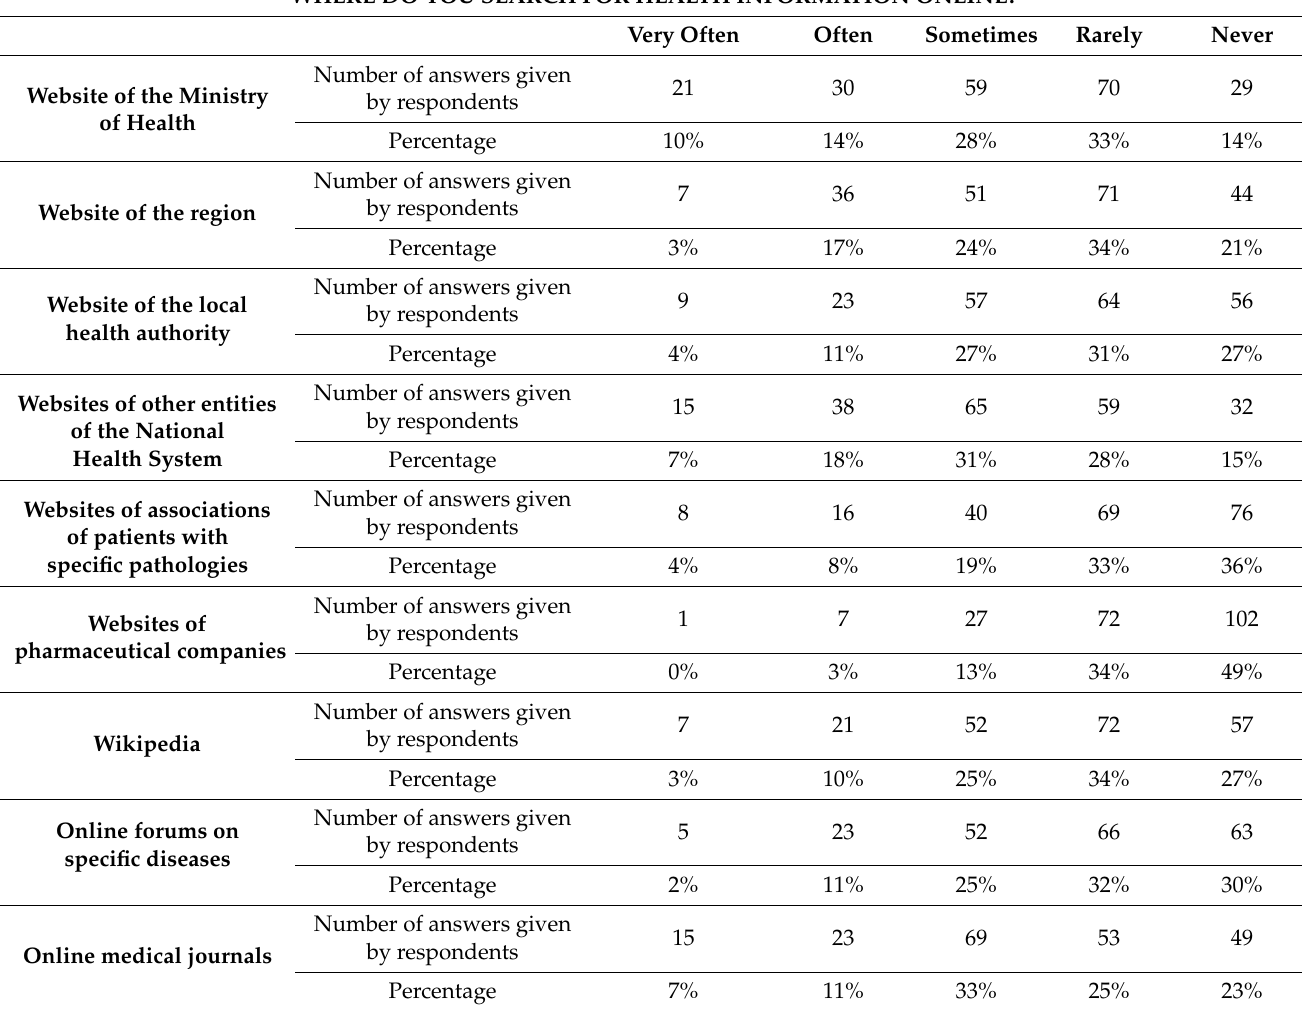
Table 5. Websites and media are used for searching online health